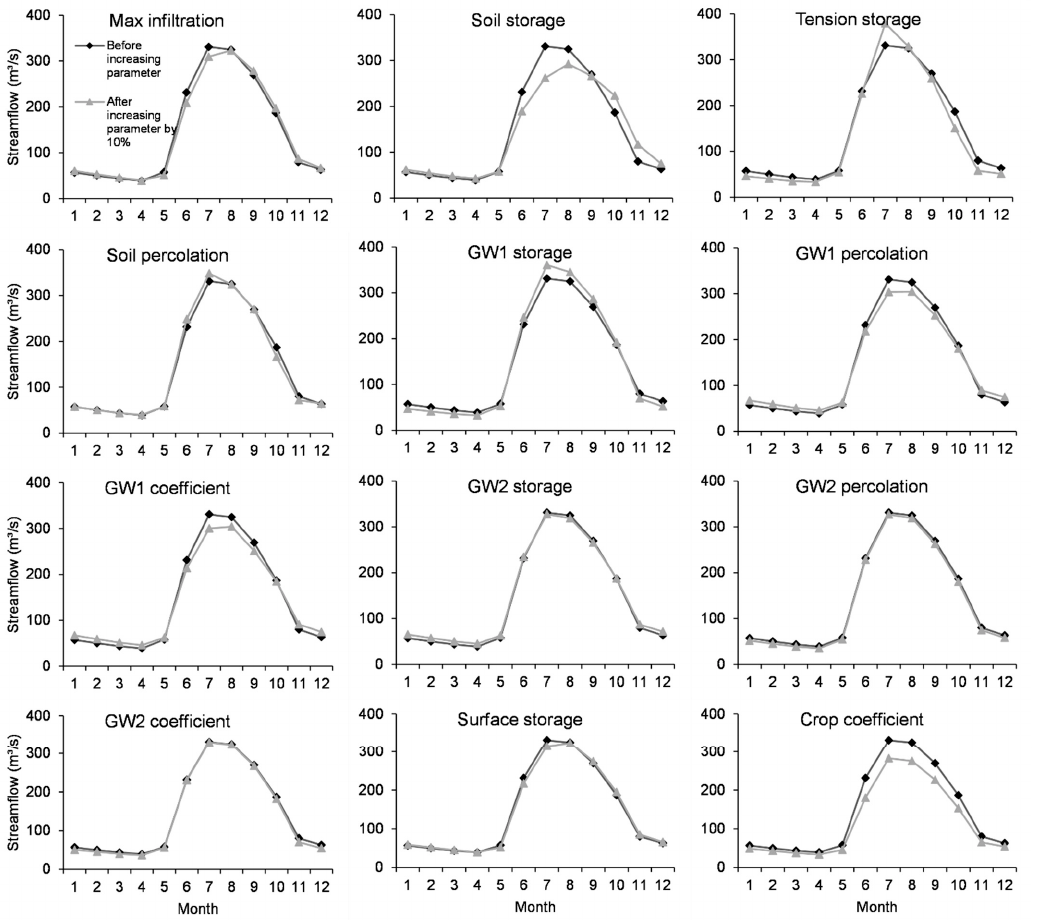
Figure 6. The effects of hydrological parameters on the components (e.g., falling limb, rising limb, peak flow, and low flow) of streamflow hydrograph. Black line shows the initial streamflow and gray line shows the streamflow after changing a parameter by 10%. For example, the top-left figure shows that when we increase the max. infiltration, the peak flow component lowers. Similarly, when we increase soil storage (top-middle figure), peak flow lowers and falling limb moves forward.